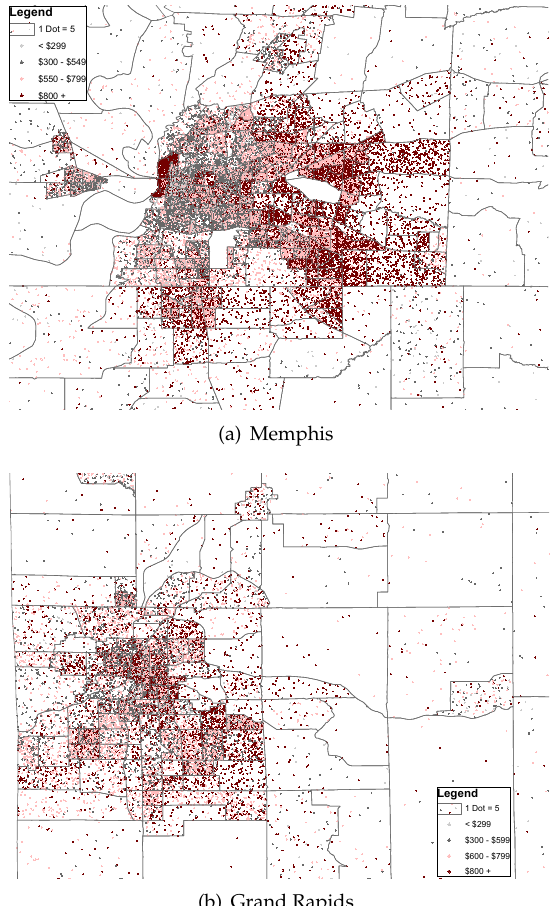
Figure 2: Rental cost segregation in the (A) Memphis and (B) Grand Rapids metropolitan areas, 2014. Note: I collapsed the 24 rent categories into four for ease of presentation. The middle two rent categories vary slightly between the two metropolitan areas to create a similar rent